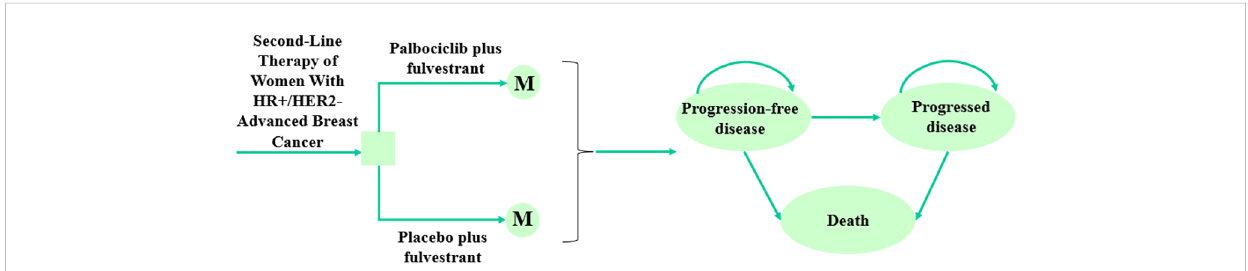
FIGURE 1 The Markov model structure and the decision tree of palbociclib plus fulvestrant versus placebo plus fulvestrant as second-line therapy of women with HR+/HER2- advanced breast cancer. HR+, Hormone receptor-positive; HER2-, Human epidermal growth factor receptor